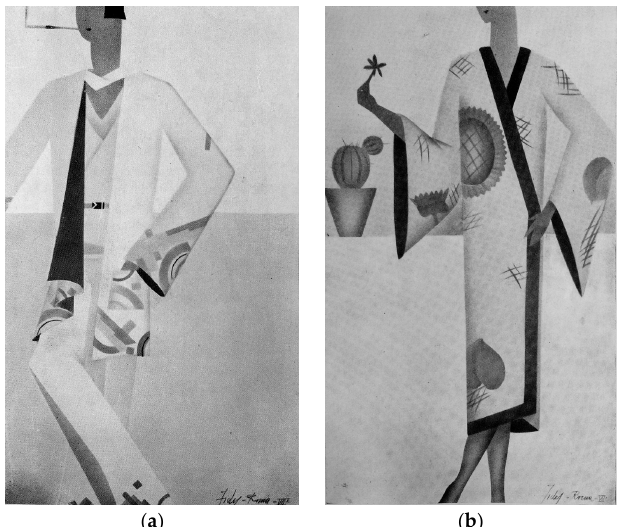
Figure 9. Fides Testi, ( a ) Pyjamas in light pink crepe painted on shades of pink and brown; ( b ) Kimono in straw colored silk fabric painted in shades of yellow and green. Photo from (Chiffon 1930). In public domain.